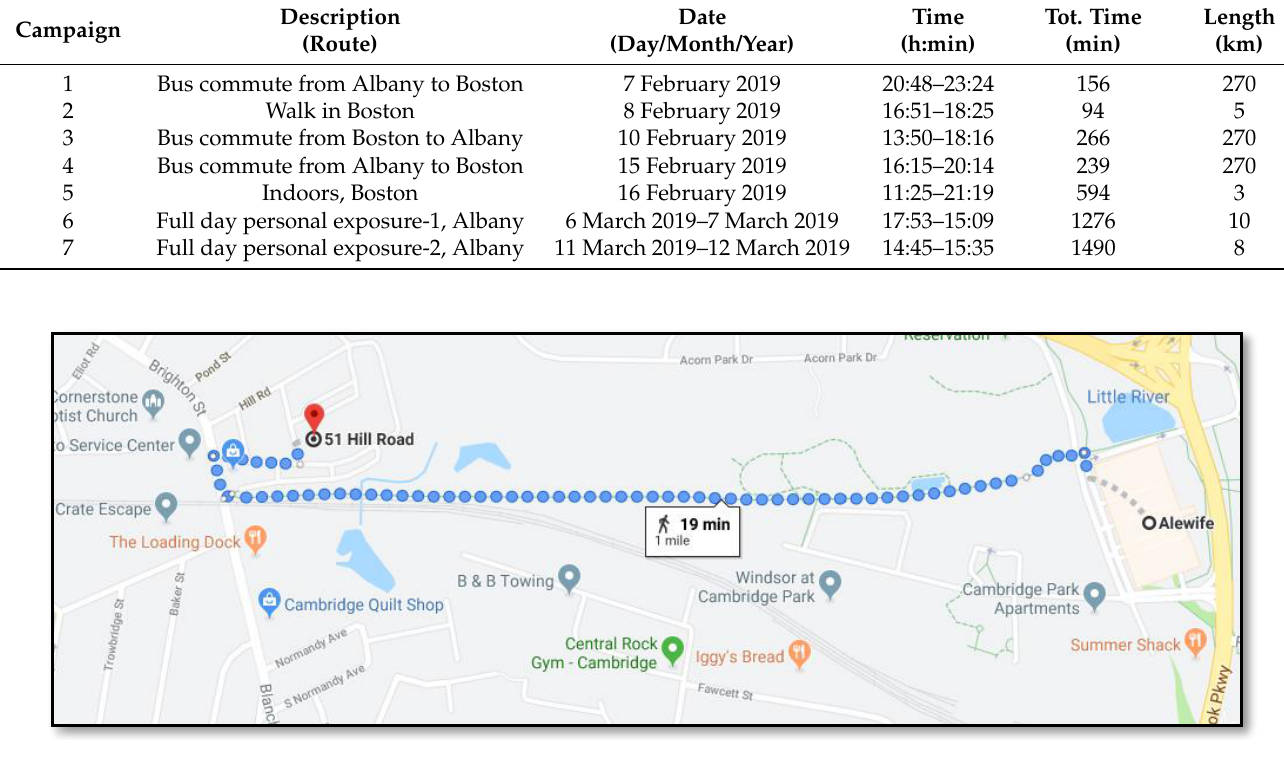
Figure 2. A scehematic diagram of the evening walk route in Boston, Massachussetts. (Source: